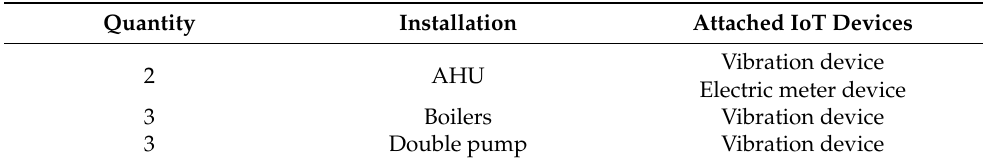
Table 1. The HVAC installations and the attached IoT